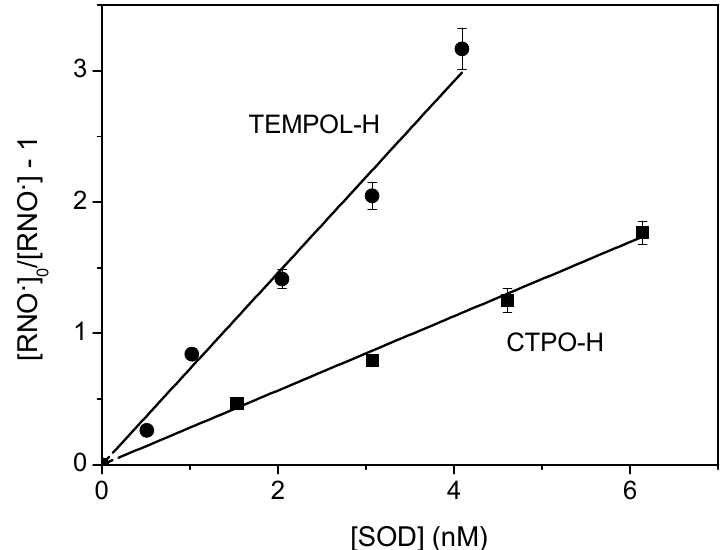
Figure 3. Reaction of superoxide with hydroxylamine. Competition kinetics using SOD as a reference solute. The accumulated [RNO • ] was monitored upon irradiation of oxygenated solution con ‐ taining 1 mM CPTO ‐ H ( ) or TEMPOL ‐ H ( ), 0.1 M formate, 50 μ M DTPA, 10 mM PB, pH 7.8, in the absence and in the presence of various concentrations of SOD where [RNO • ] 0 denotes the accu ‐ mulated concentration of nitroxide in the absence of SOD.